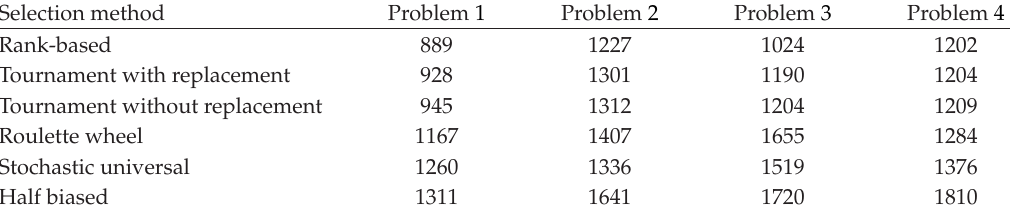
Table 9: Convergence speed of the CGA using di ff erent selection schemes.